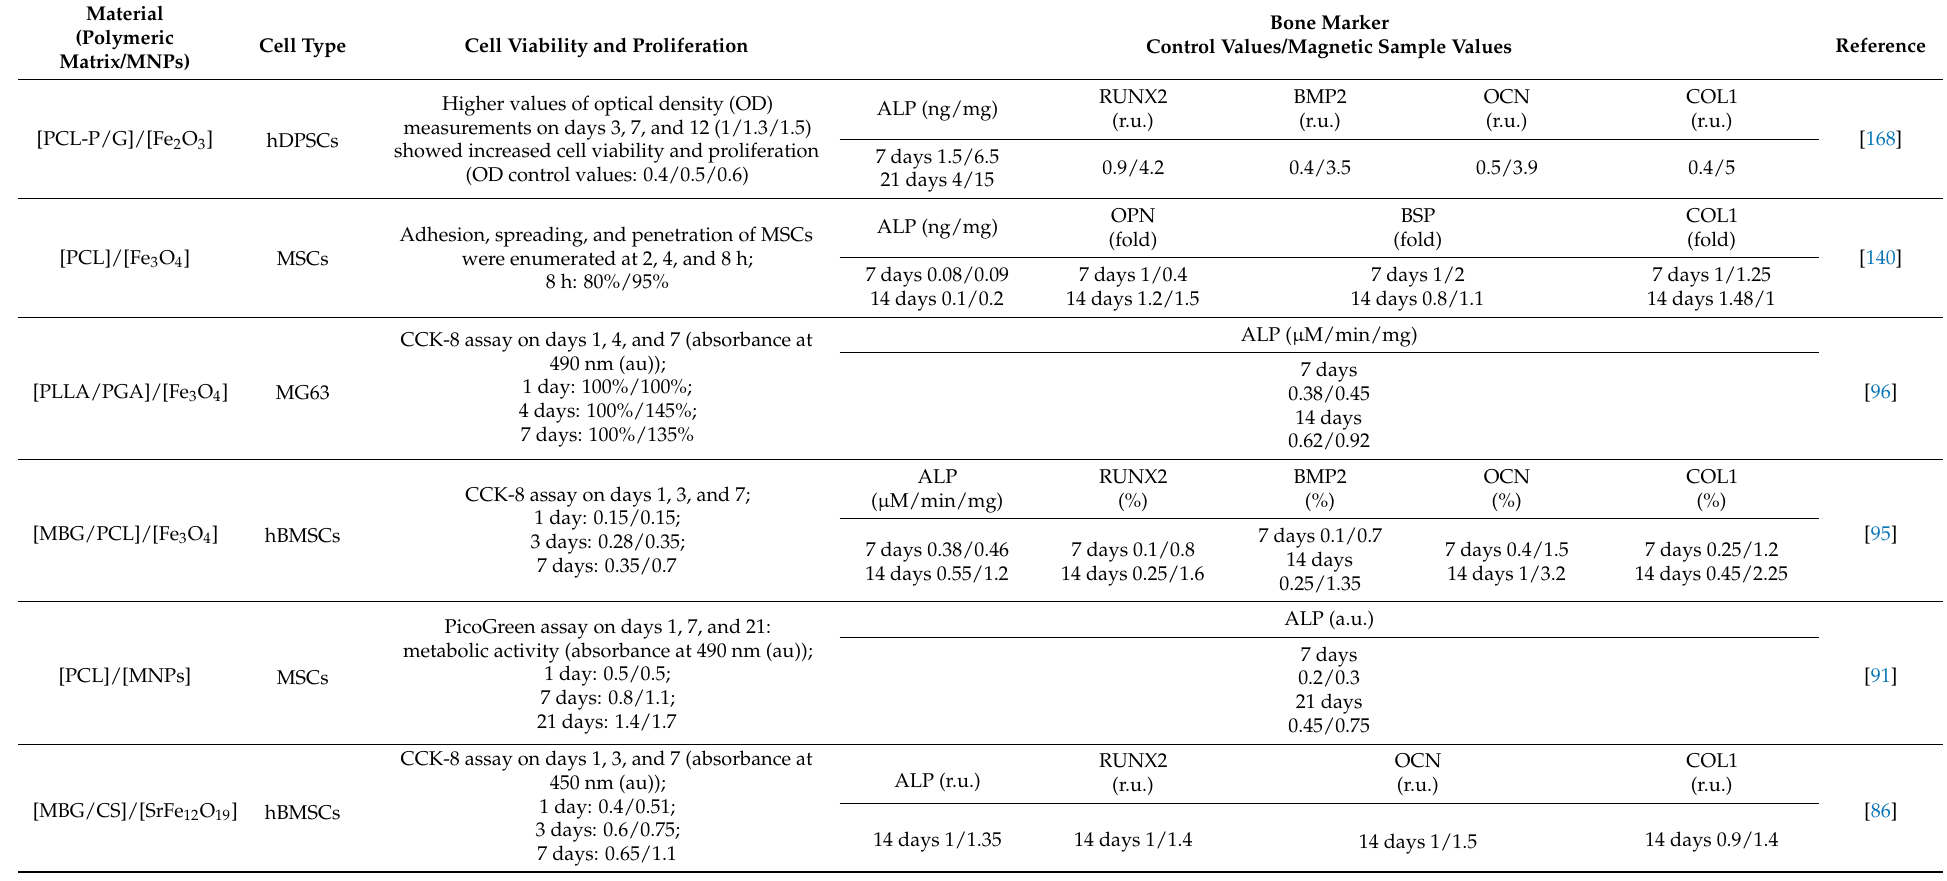
Table 5. Cell viability, cell proliferation, and bone markers of some magnetic polymeric scaffolds used in